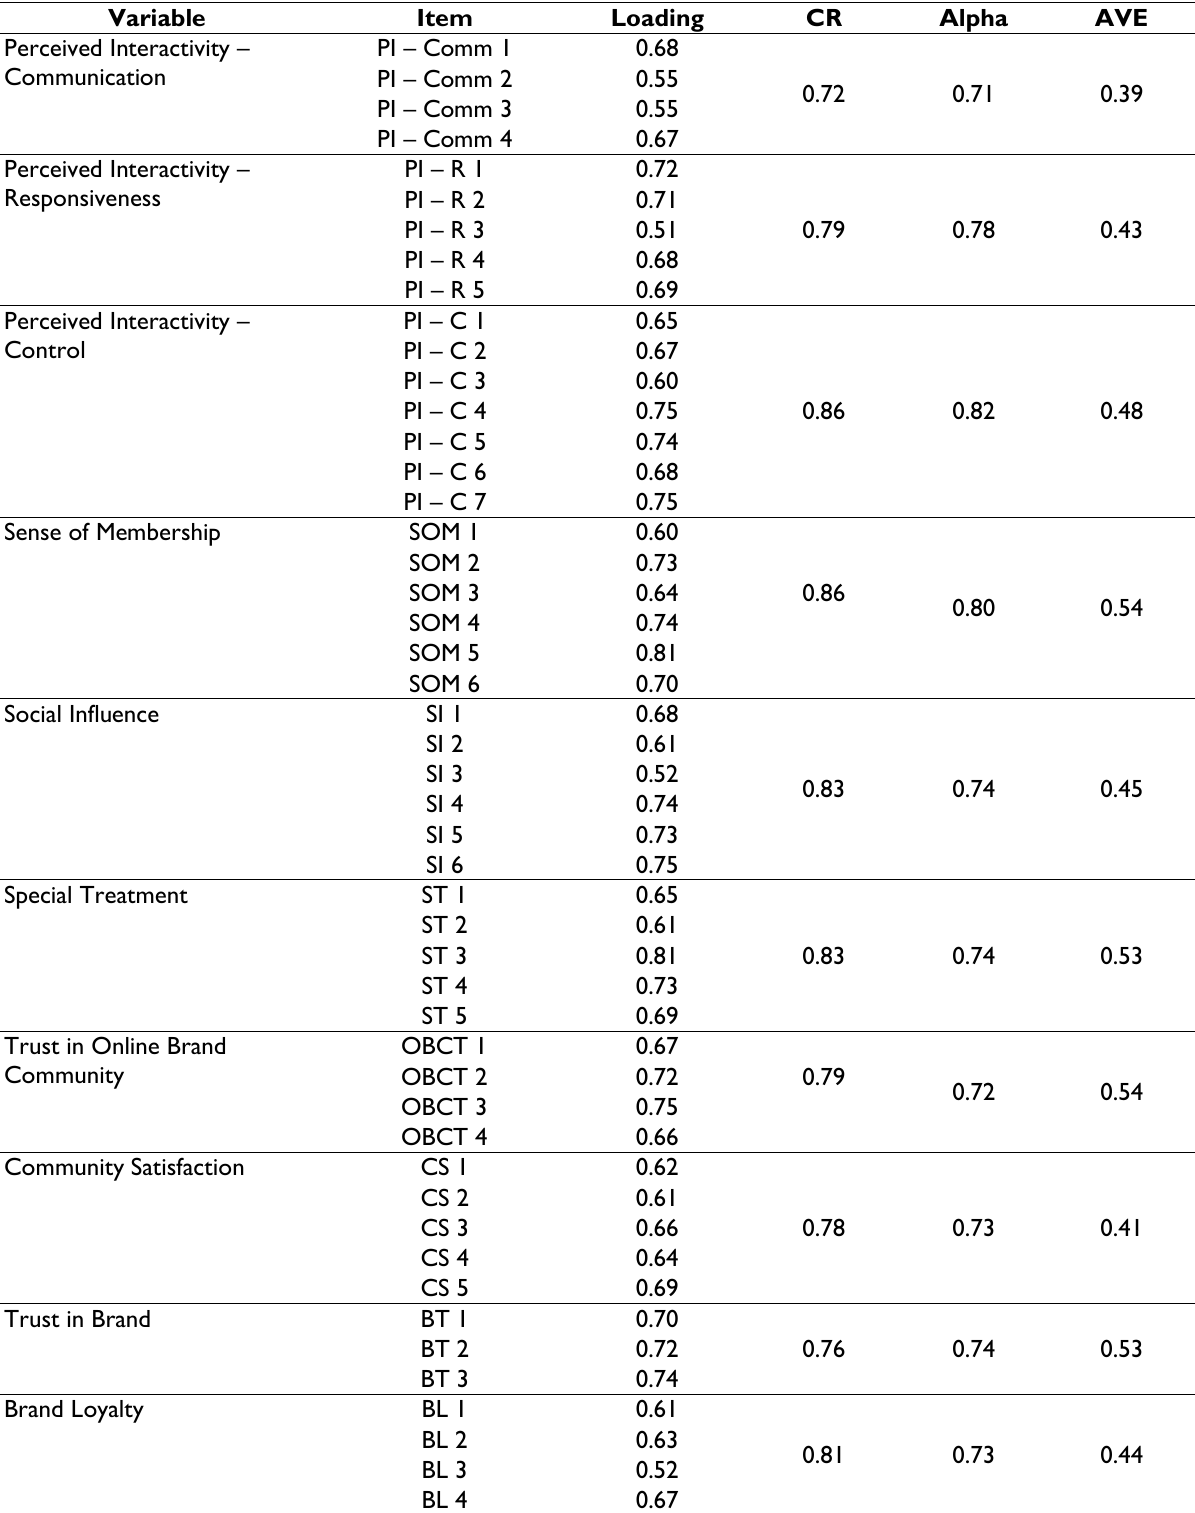
Table 3. Composite Reliability and Convergent Validity Test